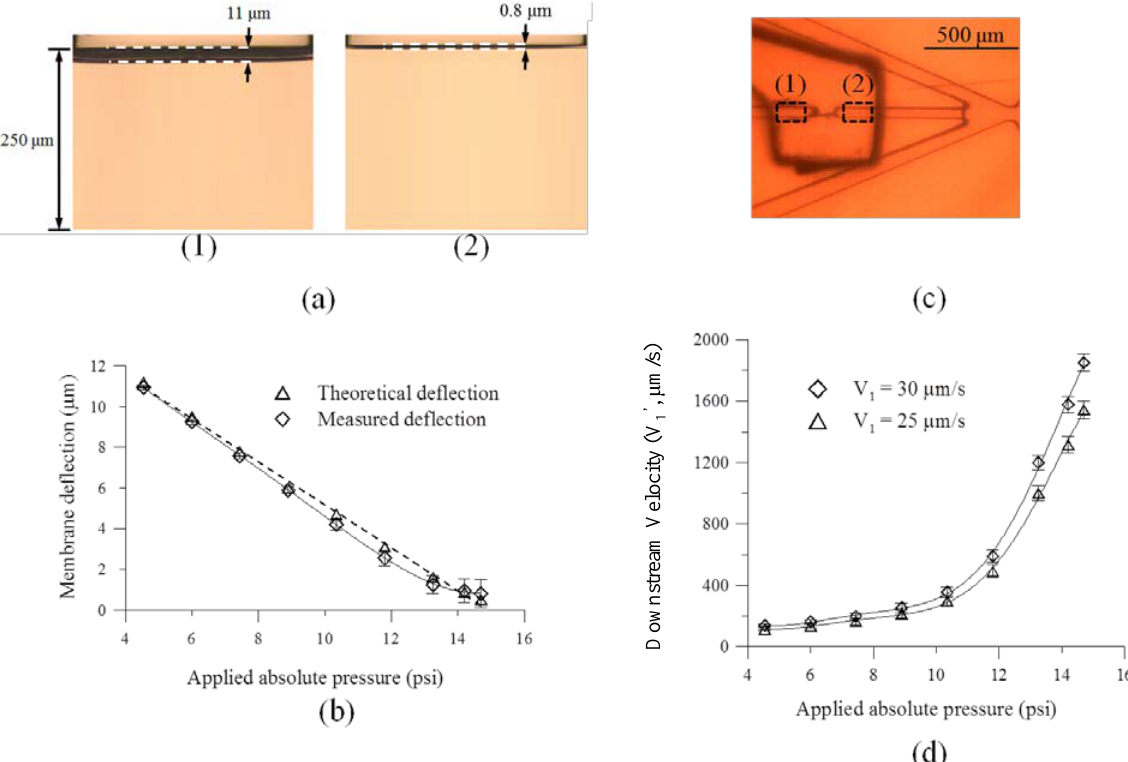
Figure 4. ( a ) The maximum deflection of membrane were measured as (1) 11 μm (for 4.5 psi) and (2) 0.8 μm (for 14.7 psi), respectively. ( b ) The membrane deflection of the NC micro-valve at different applied absolute pressures. Note that the initial membrane defection is 0.8 μm when the syringe pumps are activated. ( c ) The upstream and downstream flow velocities were measured in the (1) upstream and (2) downstream regions which were distant form the NC valve with 200 μm, respectively. ( d ) The downstream velocity of the dispersed-phase liquid ( V ’) after flowing through the NC micro-valve when 1 operated at different suction pressures. The velocity of the continuous-phase liquid ( V ) is 2 set at 50 μm/s. Two experiments with two different upstream (initial) velocities of the dispersed-phase liquid ( V ) of 25 and 30 μm/s, respectively, are 1